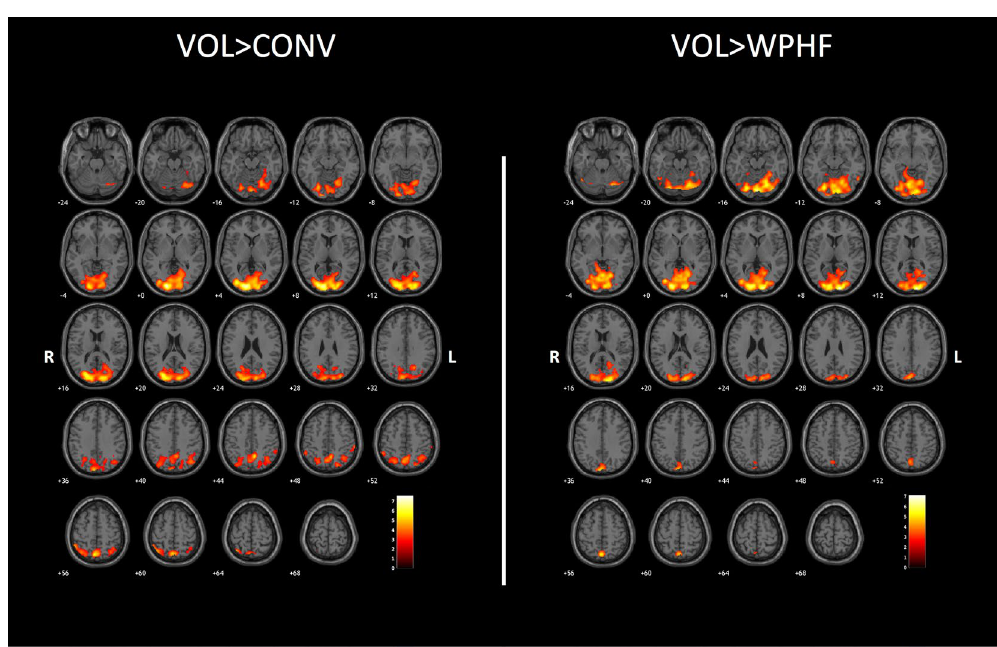
Figure 4. Whole brain contrast maps ( p < 0.005; k = 20; FDR corrected at cluster level p < 0.05) between VOL and the two NMES protocols. Statistical maps were coregistered with the SPM-MNI single subject T 1 images. The color scale represents the T values. R: right hemisphere; L: left